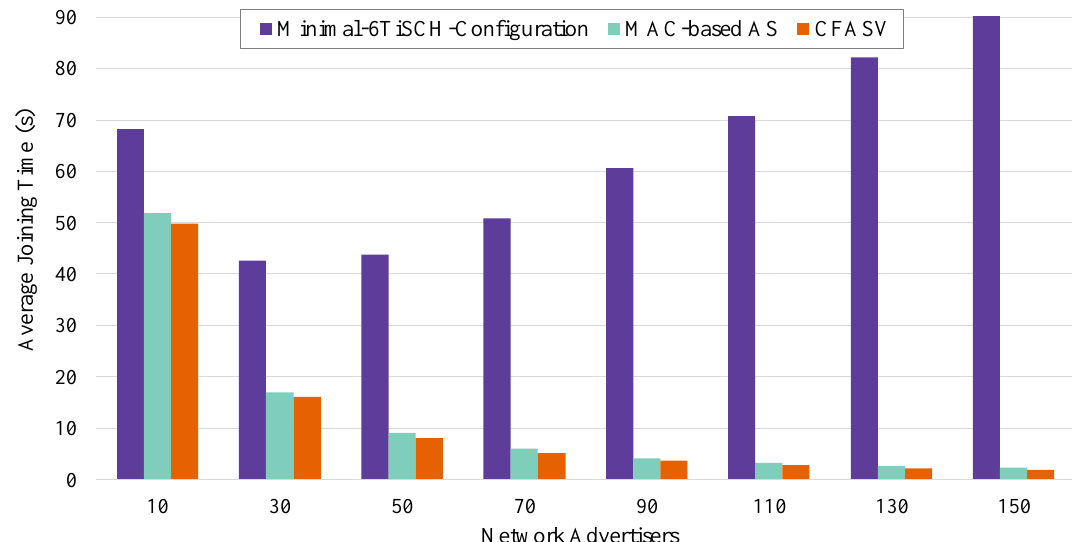
Figure 15. Comparison of CFASV and its MAC-based alternative with the minimal 6TiSCH configuration for a mobile joining node.